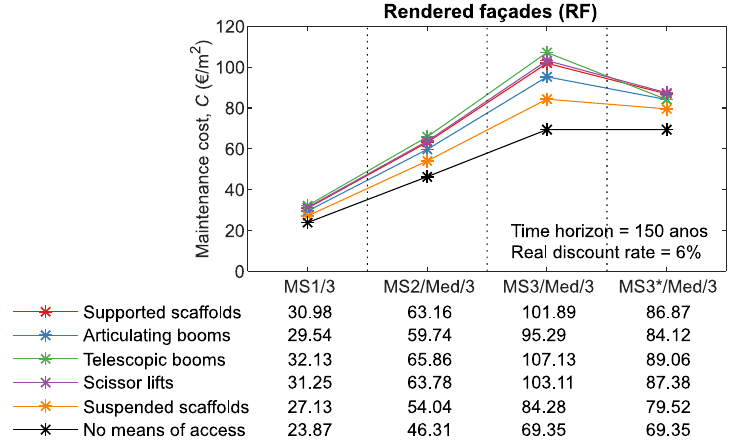
Figure 4. Sensitivity analysis of the different means of access in RF maintenance strategy costs for a time horizon of 150 years.